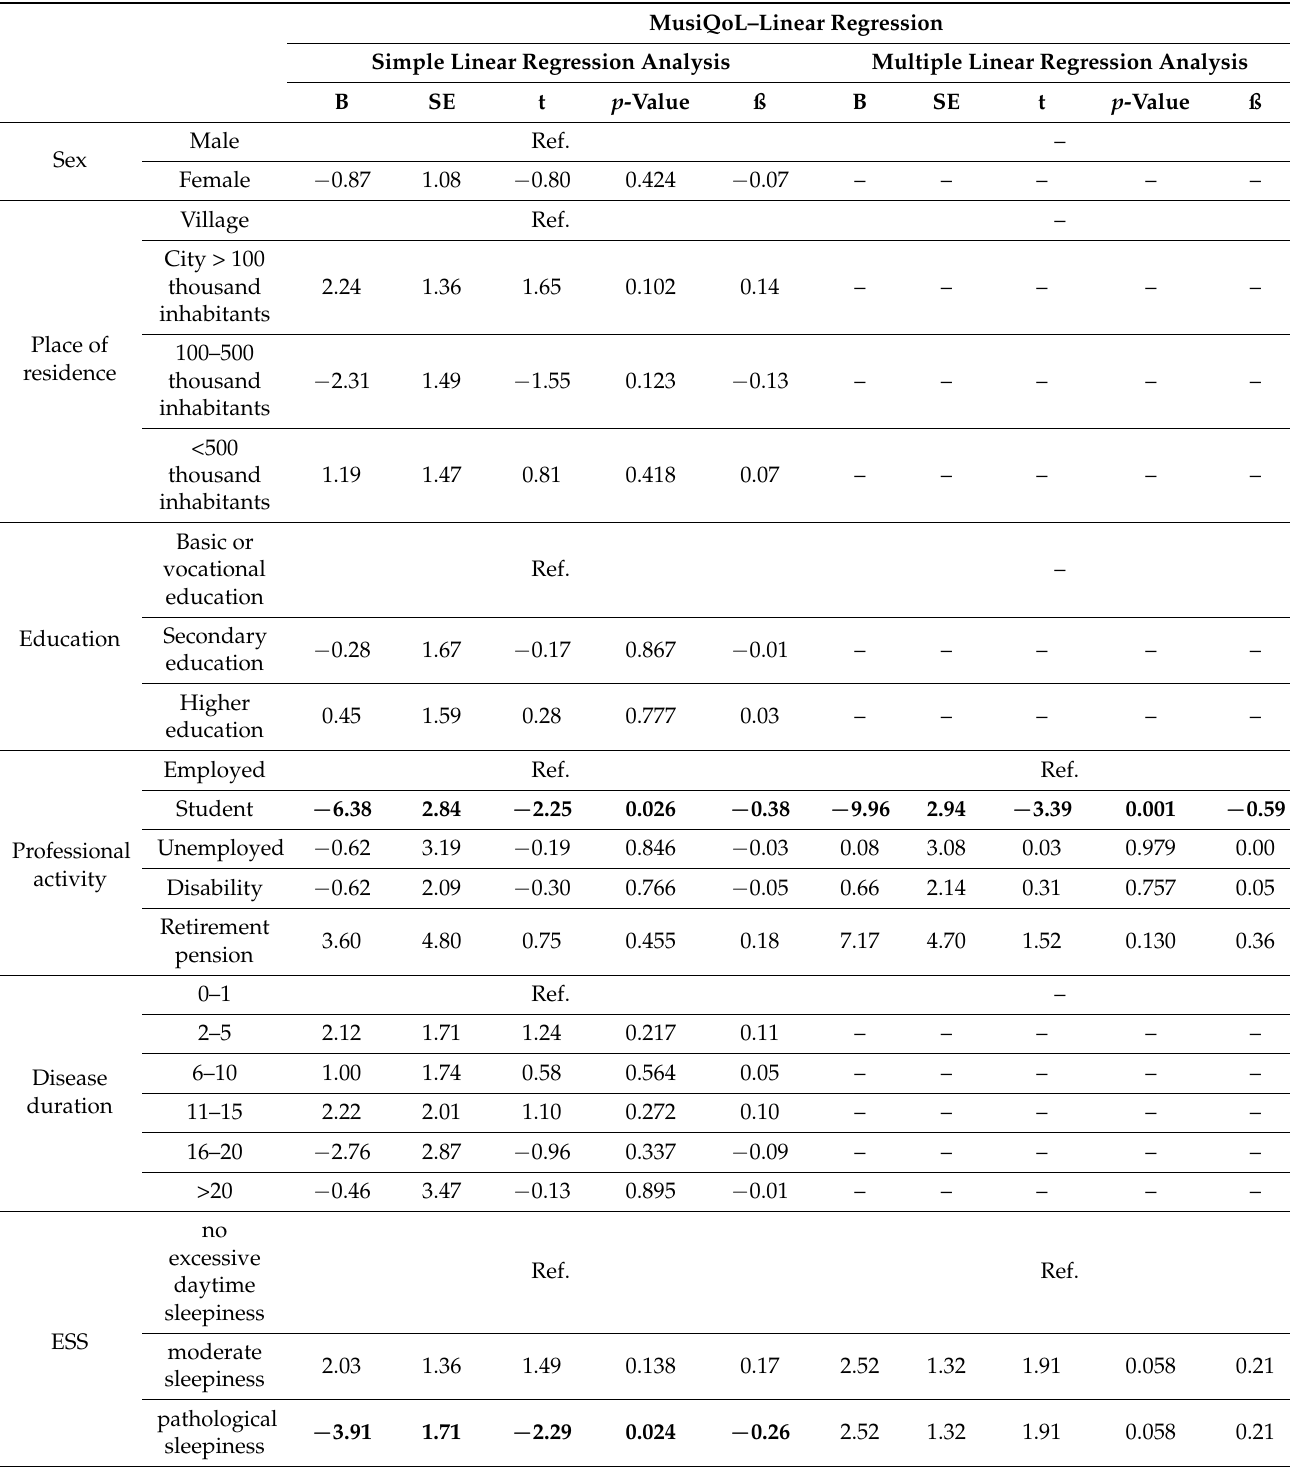
Table 4. Linear regression